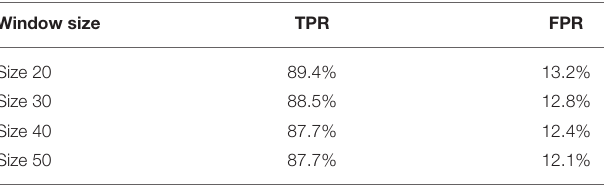
TABLE 5 | Performance comparison with different sliding window sizes with a threshold of 0.5.